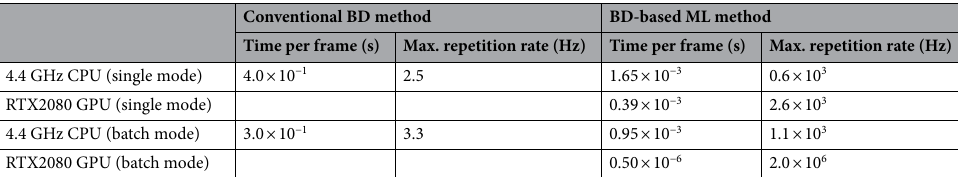
Table 2. The speed test is done in both the single mode and the batch mode. The batch mode is to apply the method to 5000 frames at once, while the single mode is to apply the method to one frame at a